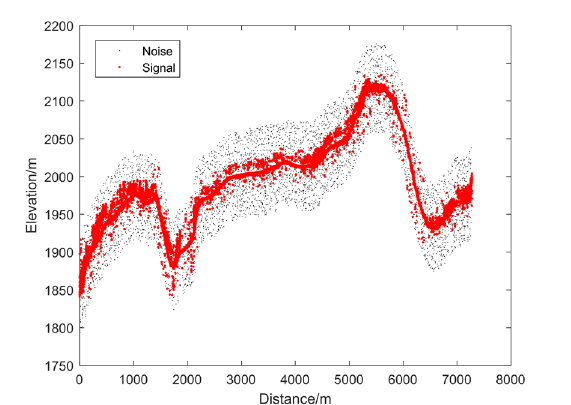
Figure 9 . Filter result based on topographic continuity.